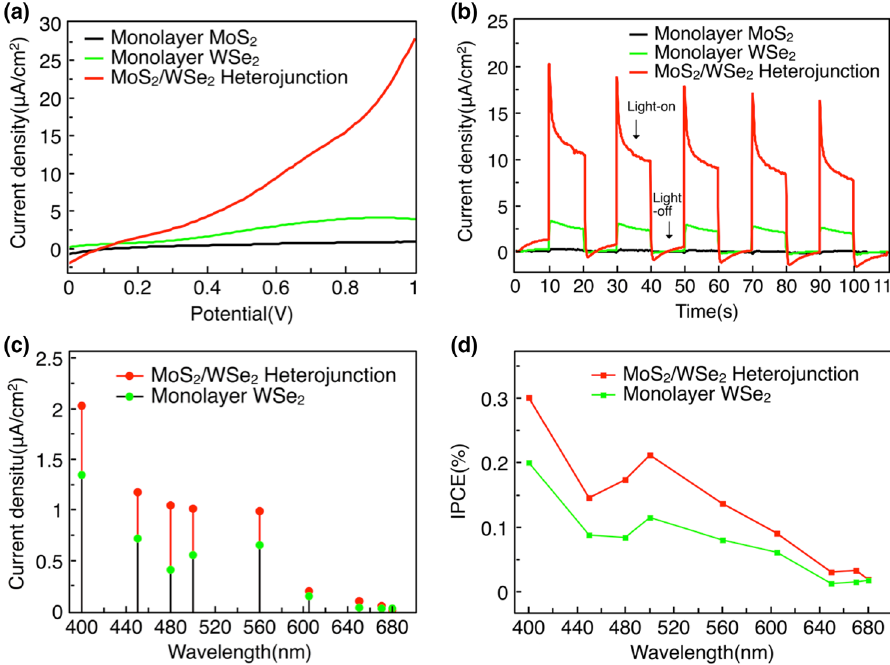
Fig. 3 a PEC current density versus voltage ( J – V ) curves of MoS 2 /WSe 2 heterojunction (red), monolayer WSe 2 (green), and monolayer MoS 2 (black) under the same white light illumination conditions. b Current response curves for the three samples under 1 V external bias with illumination an interval of 10 s. c PEC currents of monolayer MoS 2 /WSe 2 heterojunction (red dots) and WSe 2 (green dots) at different wavelengths. d IPCE of MoS 2 /WSe 2 heterojunction (red dots line) and WSe 2 (green dots line). (Color figure